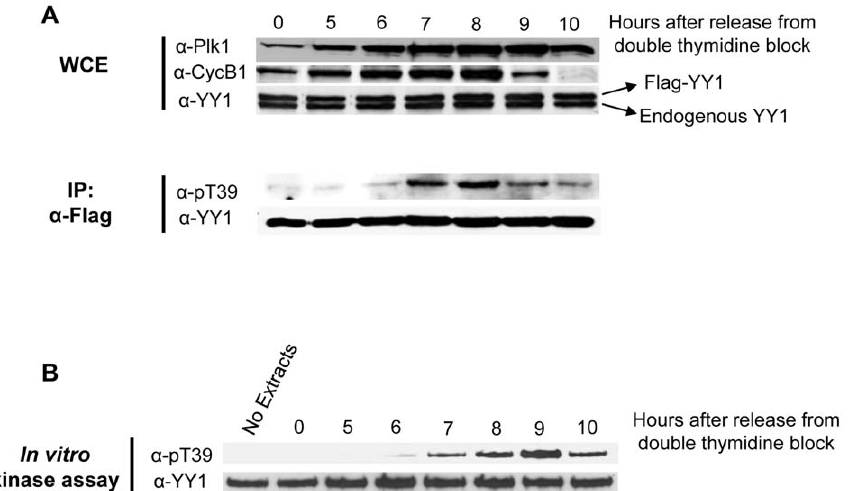
Figure 6. YY1 phosphorylation at T39 is rapidly dephosphorylated upon entry into mitosis. Stable HeLa-Flag-YY1 cells were synchronized by double-thymidine block and then released. Cells were collected for WCE preparation at the indicated time points. ( A ) Western blot analysis of HeLa WCEs and immunoprecipitated Flag-YY1 at the indicated time points. WCEs were probed with anti-Plk1, anti-Cyclin B1, and anti-YY1 antibodies. Immunoprecipitated Flag-YY1 was probed with anti-pT39 and anti-YY1 antibodies. ( B ) In vitro kinase assay using the same WCEs tested in (A) at the indicated time points with GST-YY1 attached to beads, in the presence of phosphatase inhibitors. Reactions were separated on SDS-PAGE, transferred to nitrocellulose membrane, and probed with anti-pT39, then anti-YY1 antibody.